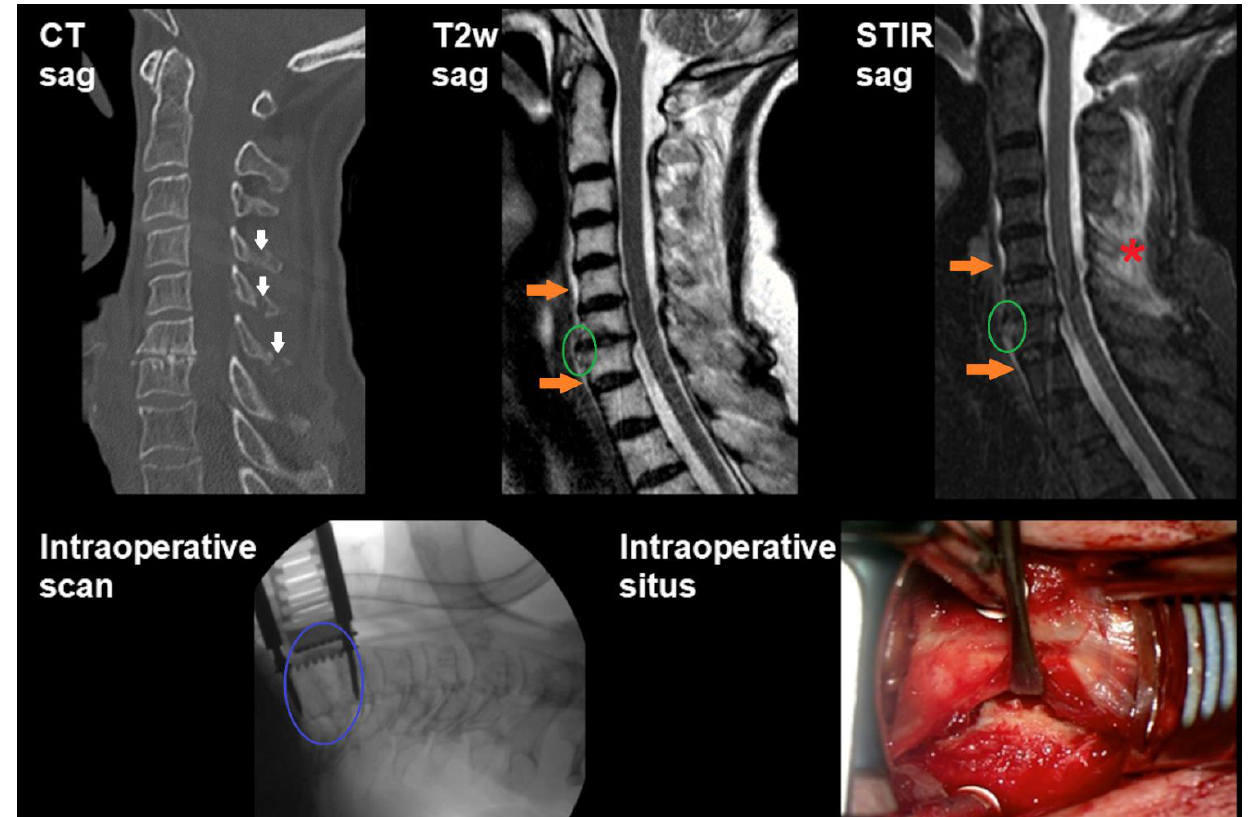
Figure 1. Preoperative imaging shows fractures of the spinous processes C4, C5, and C6 according to computed tomography (CT; white arrows ). Cervical magnetic resonance imaging (MRI), using sagittal T2-weighted and short tau inversion recovery (STIR) sequences, reveals a small prevertebral hematoma ( orange arrows ) as well as ligamentous injury ( green circles ) and edema in the nuchal soft tissue ( red asterisk in STIR imaging). Intraoperative X-ray shows a gaped intervertebral space between C6/7 ( blue circle ), indicative of instability at the lower cervical spine. Furthermore, damage to the intervertebral disc between C6/7 as well as a total rupture of the anterior longitudinal ligament (ALL) were revealed during intraoperative situs inspection according to microscopic view during surgery (depicted is the surgical access route and traumatically damaged tissue in the context of surgical stabilization due to disco-ligamentous injury). Indication for surgical treatment was based on neurological deficits in terms of a central cord syndrome.